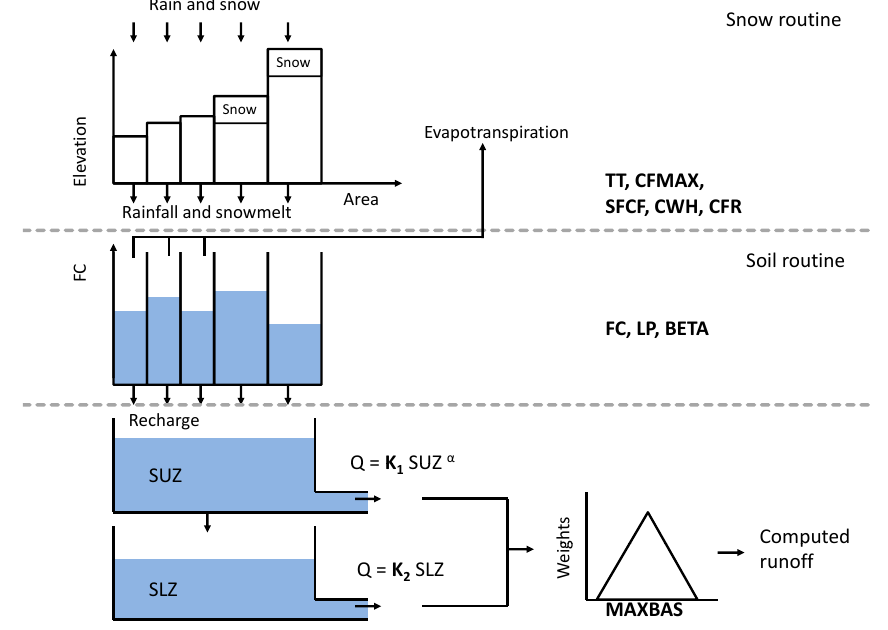
Figure 1. Structure of the HBV model.